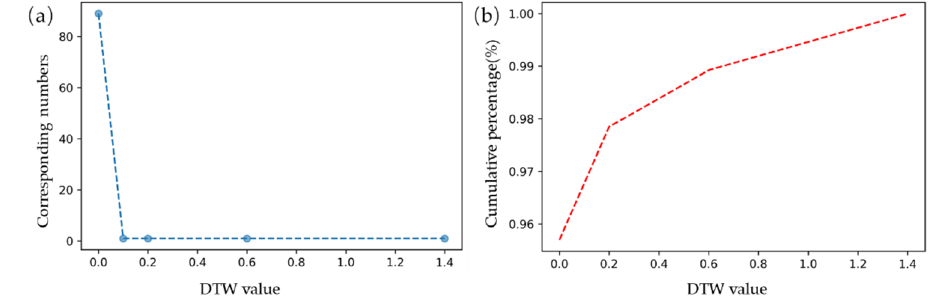
Figure 16. Distance for the SS change calculated using DTW. ( a ) Line chart of the DTW result distribution. ( b ) Cumulative percentage of the DTW result.